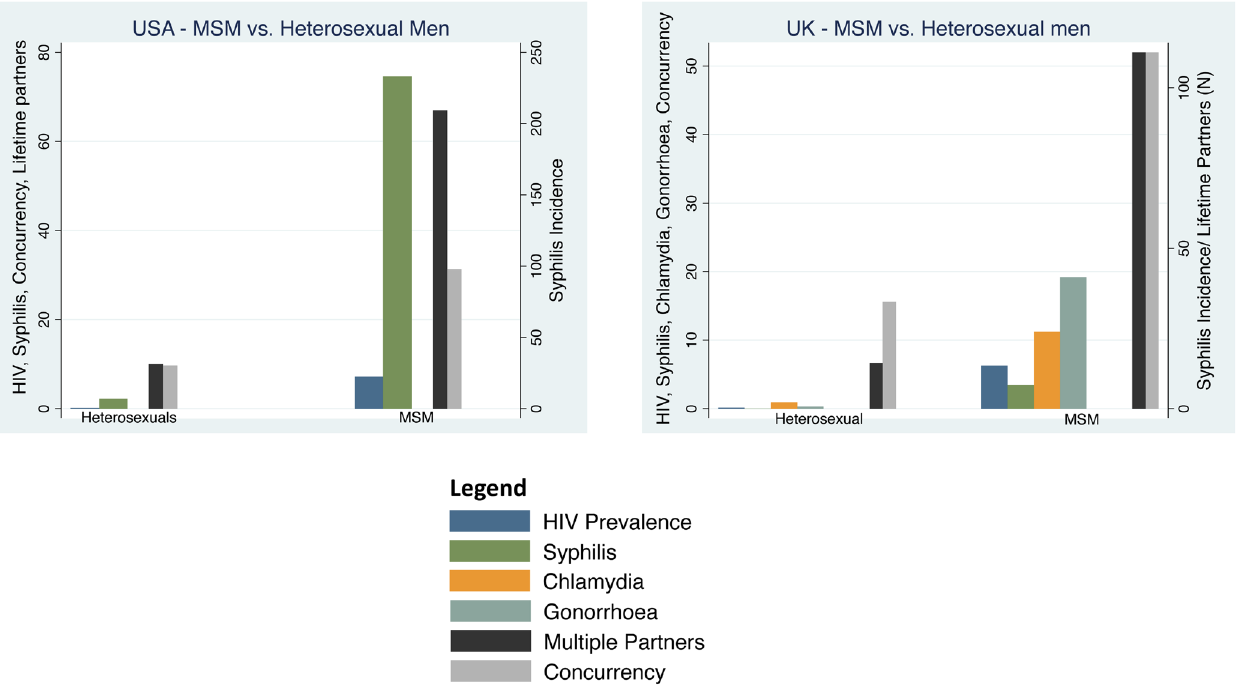
Figure 3. Incidence/prevalence of HIV, chlamydia, gonorrhoea, syphilis, partner concurrency and multiple partnering by men who have sex with men (MSM) versus heterosexual men in the United Kingdom and the United States of America. HIV and partner concurrency prevalence are reported as percentages, multiple partners as the number of lifetime partners and chlamydia, gonorrhoea and syphilis incidence as cases per 100 000 per year (Point estimates with 95% Confidence Intervals; see Table 1 for sources of